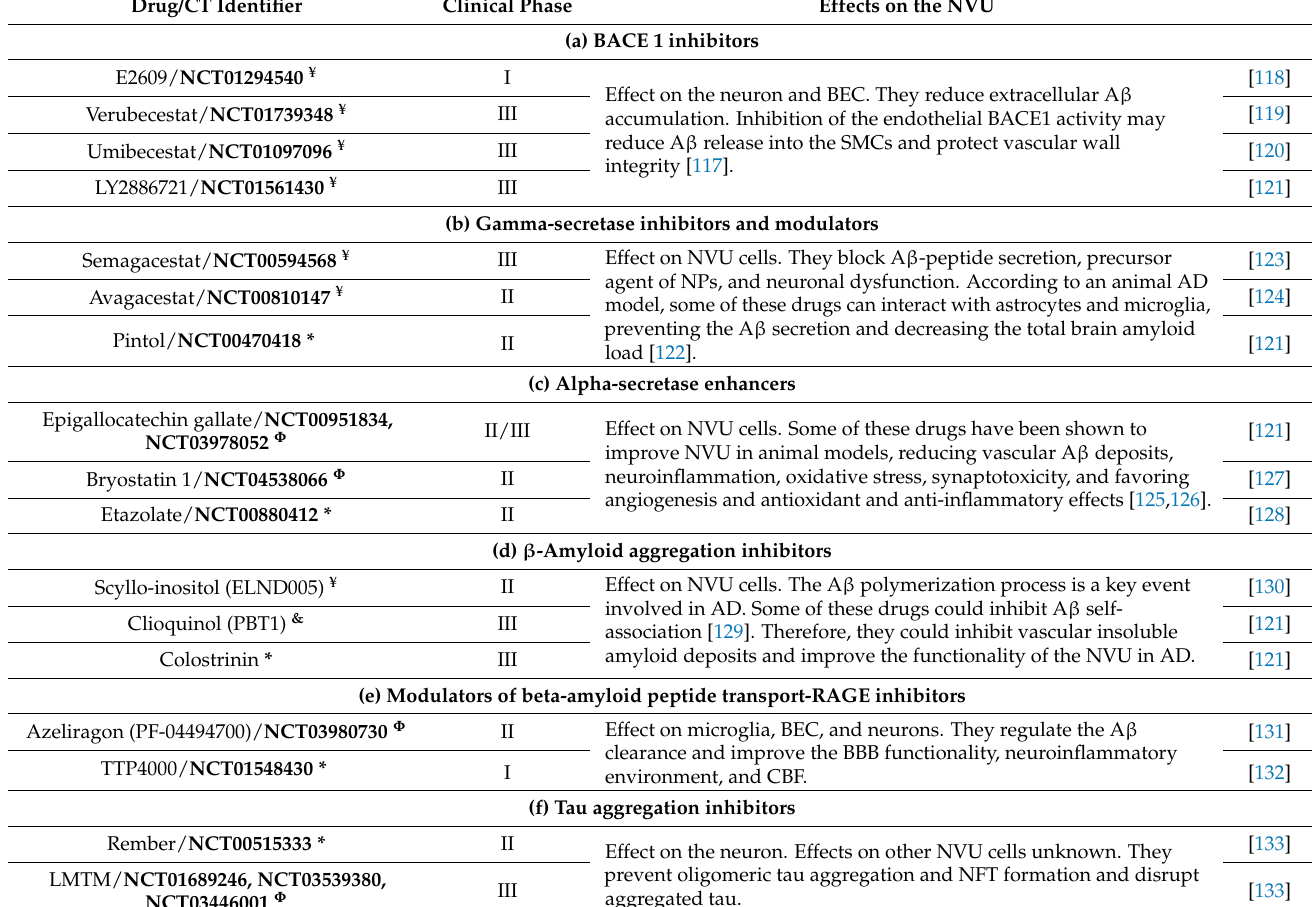
Table 2. The effects of potential AD pharmacological therapies on the NVU. Drug/CT Identifier Clinical Phase Effects on the